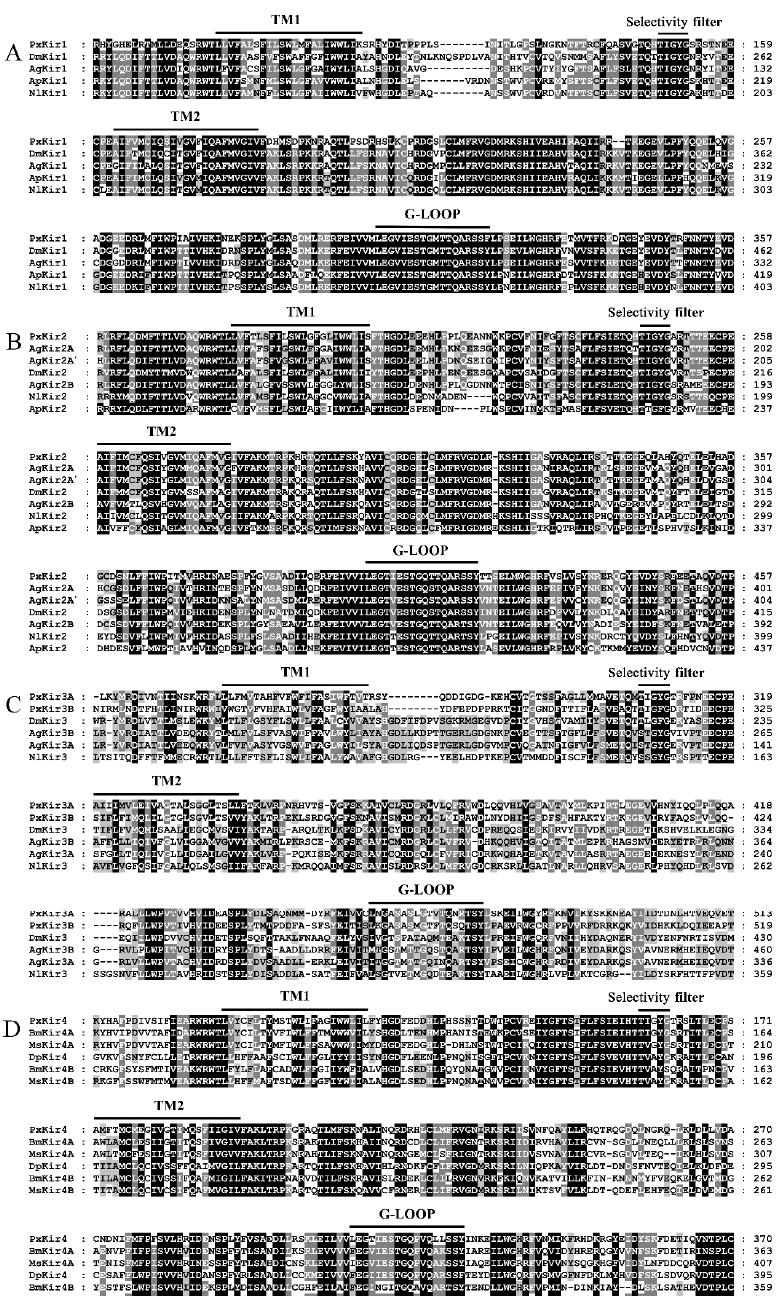
Figure3. MultiplesequencealignmentofputativePxKirsandotherorthologousproteinsinconservative domains. The respective positions are indicated on the right. Identical residues between orthologous sequences are shown as white characters against a black background, and conservative substitutions are shaded. The transmembrane helices (TM1 and TM2), the selectivity filter (SF), and the G-LOOP are highlighted with black lines. The conservative domains of Kir1 (A), Kir2 (B), Kir3 (C), and Kir4 (D) were aligned. GenBank accession numbers: A. gambiae (AgKir1, EAA01722; AgKir2A, EAA43222; AgKir2A’, EAA01723; AgKir2B, EAA43220; AgKir3A, EAL39730; and AgKir3B, AGAP028144); A. glycines (ApKir1, AG011183; and ApKir2, AG010683); D. melanogaster (DmKir1, NP_001262861; DmKir2,